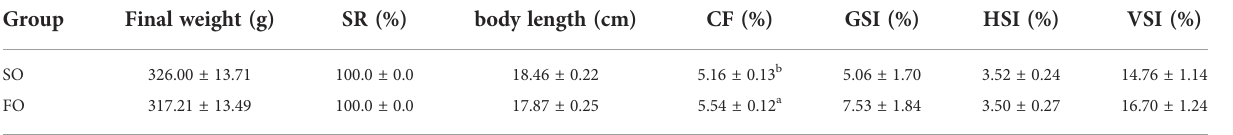
TABLE 1 Growth performance of the female adult spotted scat fed with different types of oil sources. Group Final weight (g) SR (%) SO